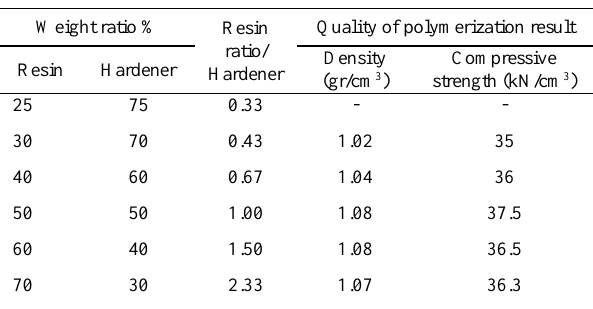
ratio of 1:1, giving the compressive strength of epoxy of 37.5 kN/Cm 2 . Table 1. Relation between mass ratio of resin and hardener to epoxy